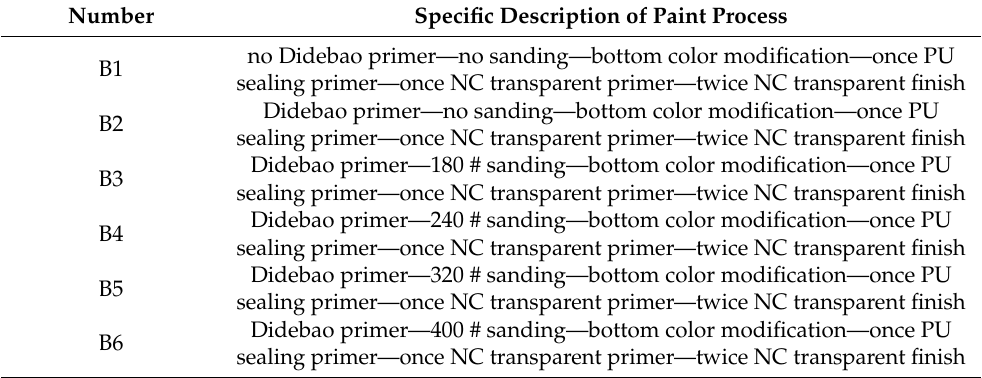
Table 2. The manufacture of specimens for Group B.